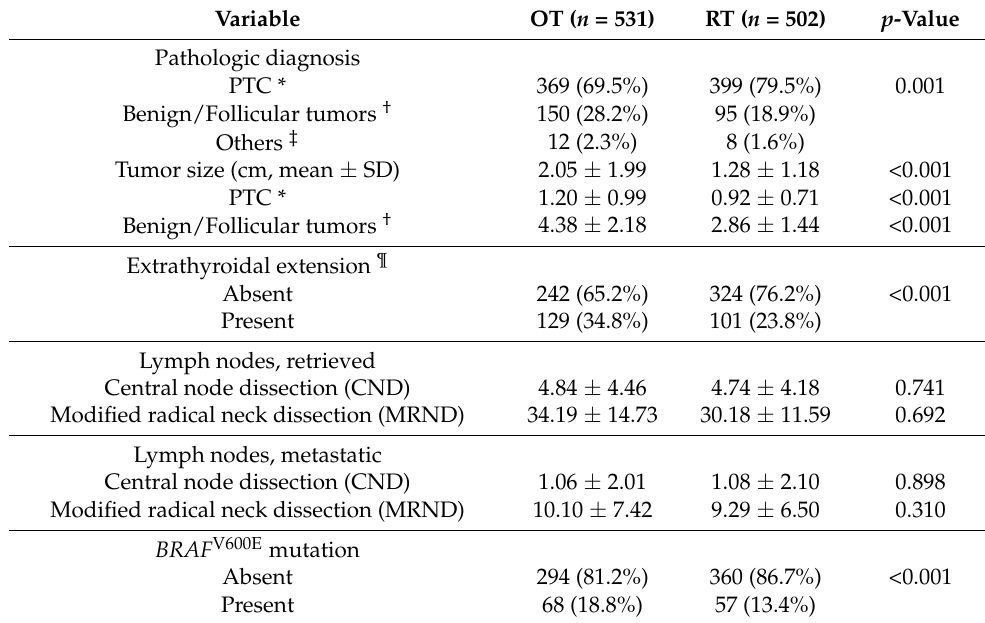
Table 2. Pathological